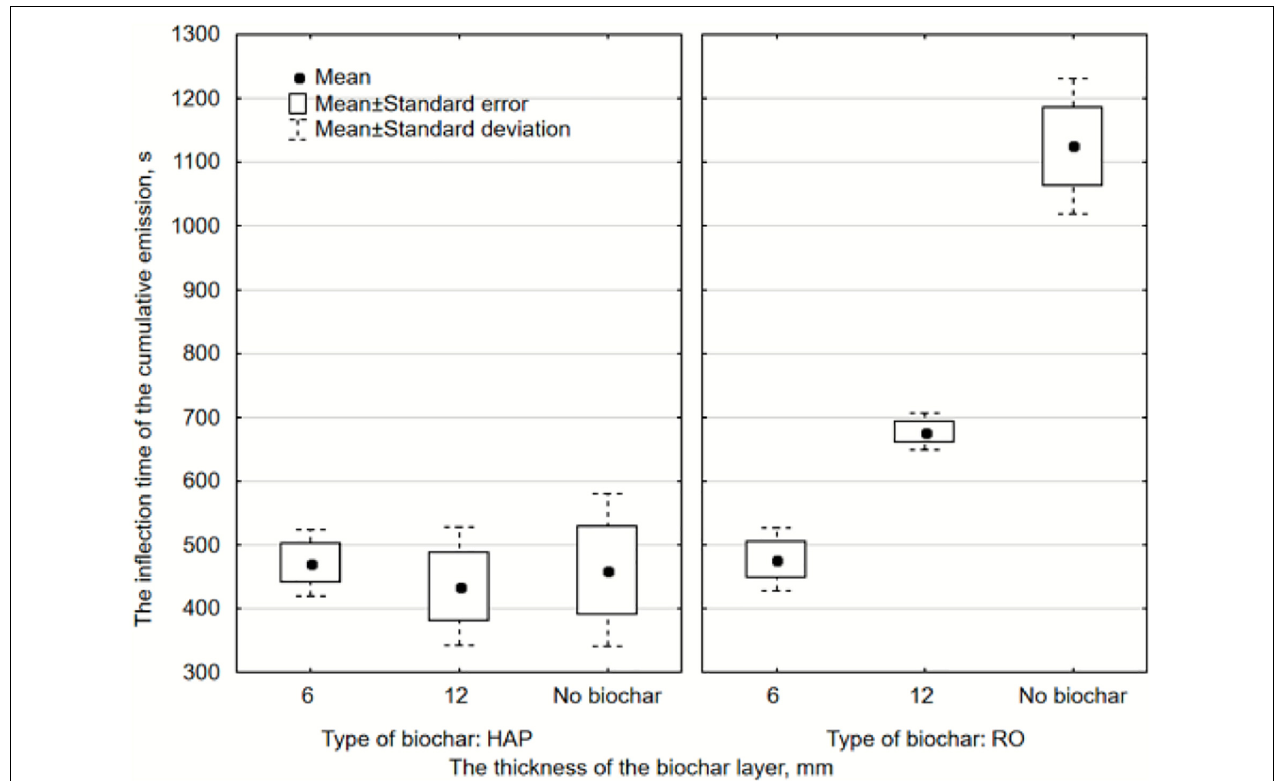
FIGURE 4 | Comparison of the inflection time a 1 of the cumulative NH 3 emission per biochar type and the dose (thickness of the layer). The biochar treatments showed significant differences ( p < 0.05) from the control; insignificant differences ( p > 0.05) between the dosages ( Appendix Table 3